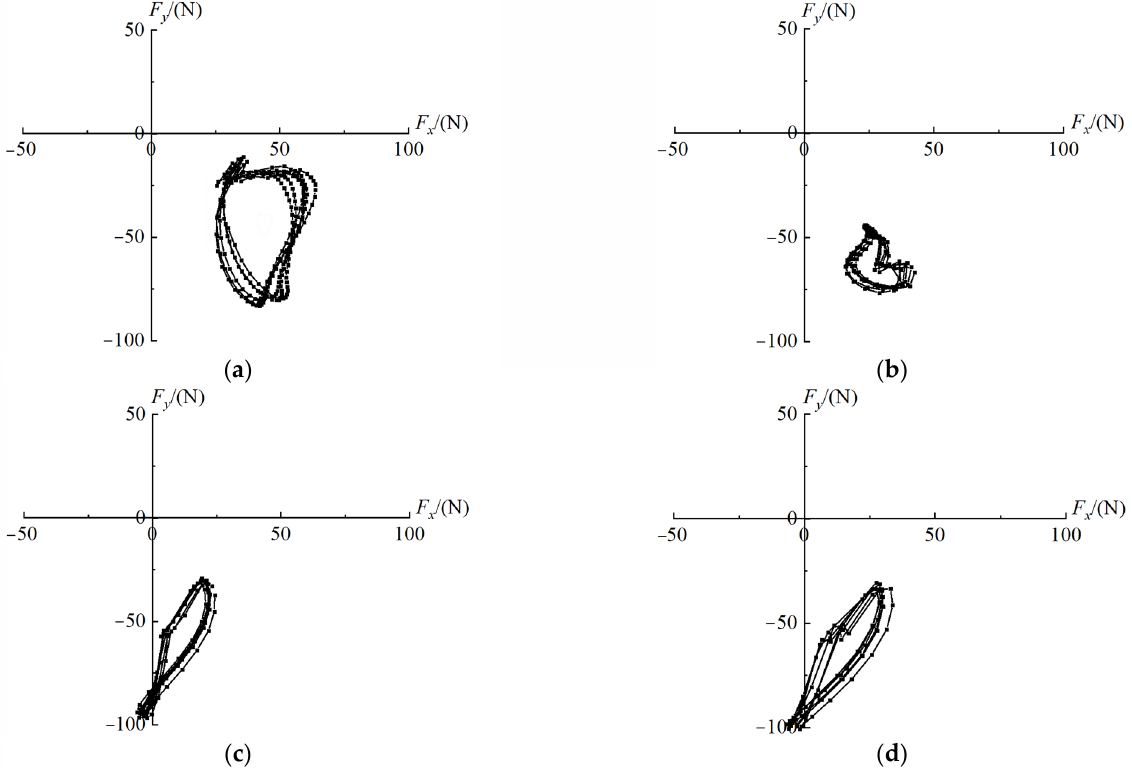
Figure 11. Vector distribution of radial force during the start ‐ up process at α g = 0.15. ( a ) t = 1 s; ( b ) t = 2 s; ( c ) t = 3 s; ( d ) t = 4 s.